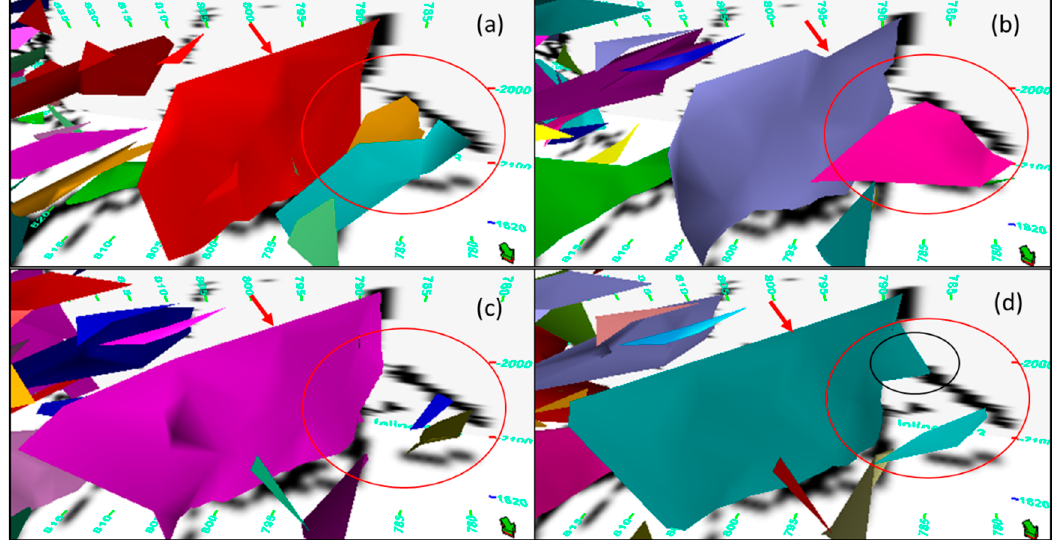
Figure 6. The extraction result of the discontinuity from the ant tracking attribute. The value of deviation from plane = 5 ( a ); the value of deviation from plane = 7 ( b ); the value of deviation from plane = 9 ( c ); value of deviation from plane = 11 ( d ).